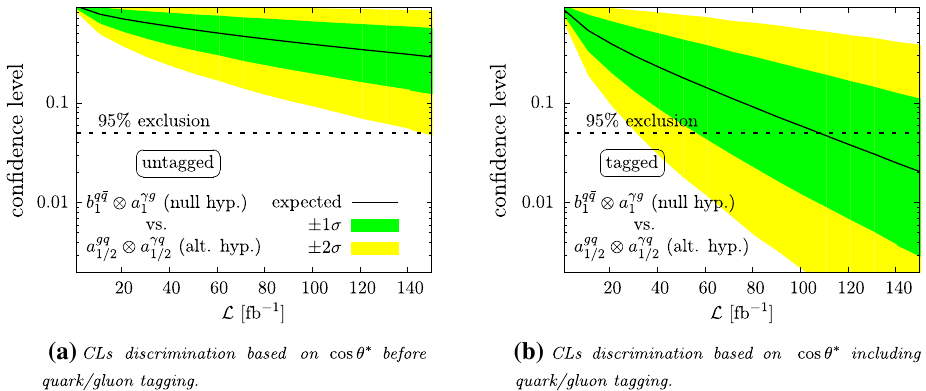
Fig. 8 Importance of quark/gluon tagging as a function of integrated luminosity. The overall signal normalisation is aligned with Fig. 9, where √ B = 5 for 300 fb − 1 luminosity in the untagged category. This amounts to a signal cross section after cuts of 23 . 4 fb we assume a S /